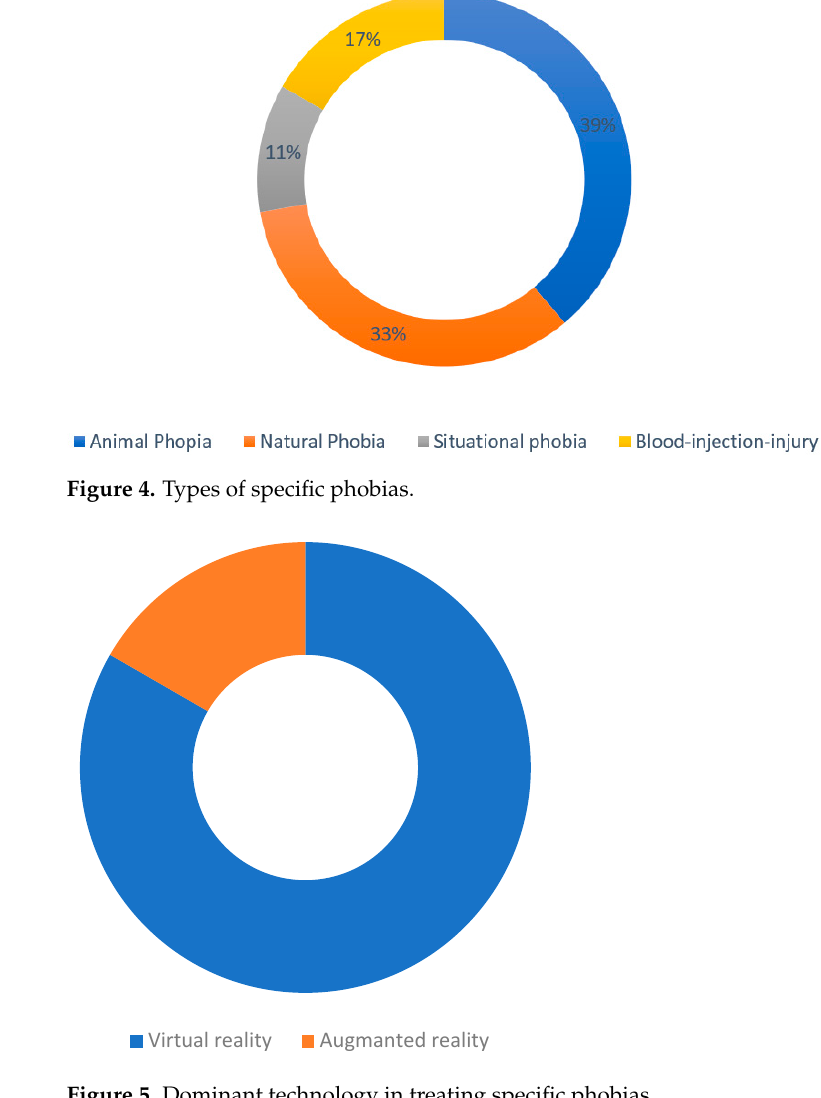
Figure 5. Dominant technology in treating specific phobias.